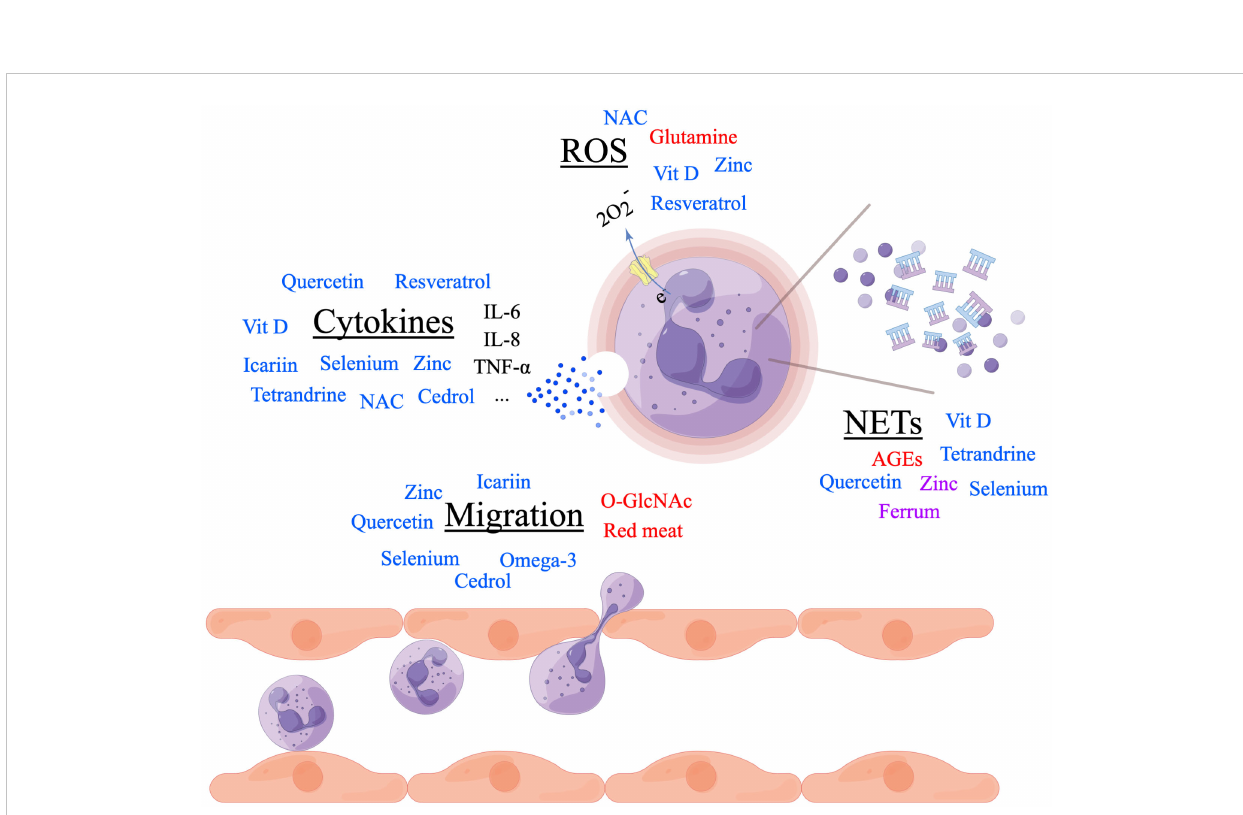
FIGURE 1 Nutrients in regulating rheumatoid arthritis (RA) through neutrophils. Nutrients in red font promote the process. Nutrients in blue font inhibit the process. Nutrients in purple font controversially in fl uence the process. Made by